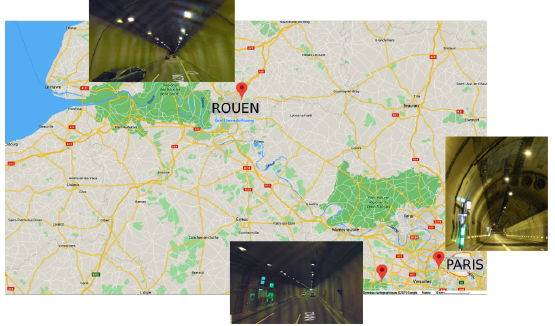
Figure 7. Localization of the surveyed